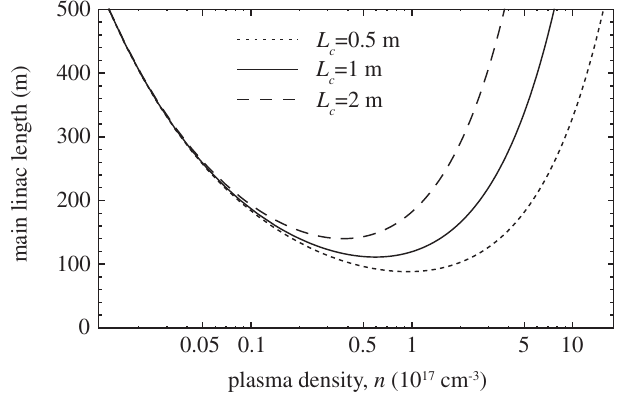
FIG. 3. Main single-linac length versus plasma density n for several laser in-coupling distances L c , for E b ¼ 0 : 5 TeV and ¼ 1 : 5 a 0